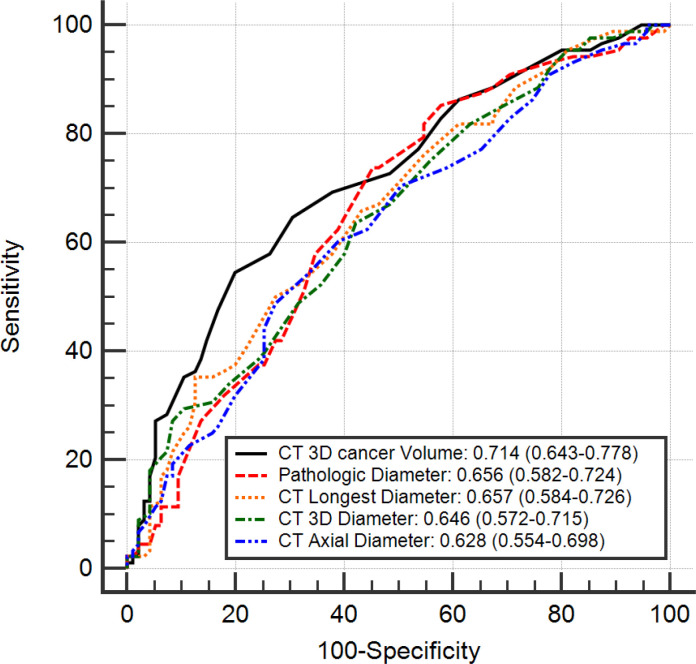
Receiver operating characteristic curves for different methods measuring pancreatic tumor size in predicting early death within 18 months.Cancer volume measured on 3D CT images demonstrated the highest area under curve (0.714; 95% confidence interval [CI], 0.643–0.778) among various size parameters.